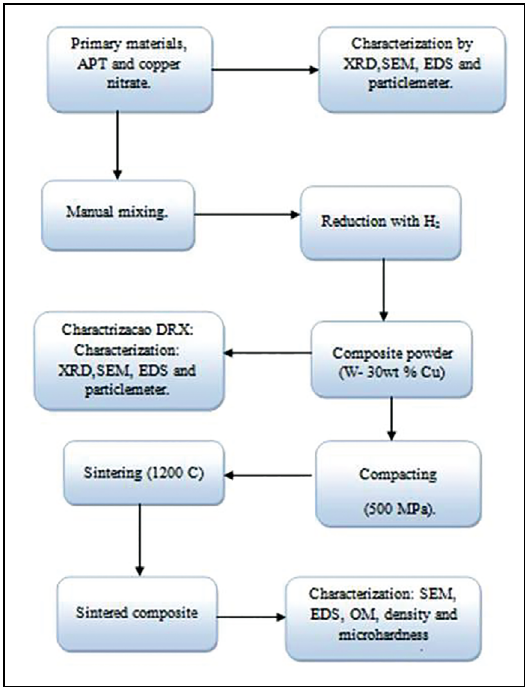
Figure 1. Process flowchart for obtaining the W-30%p.Cu